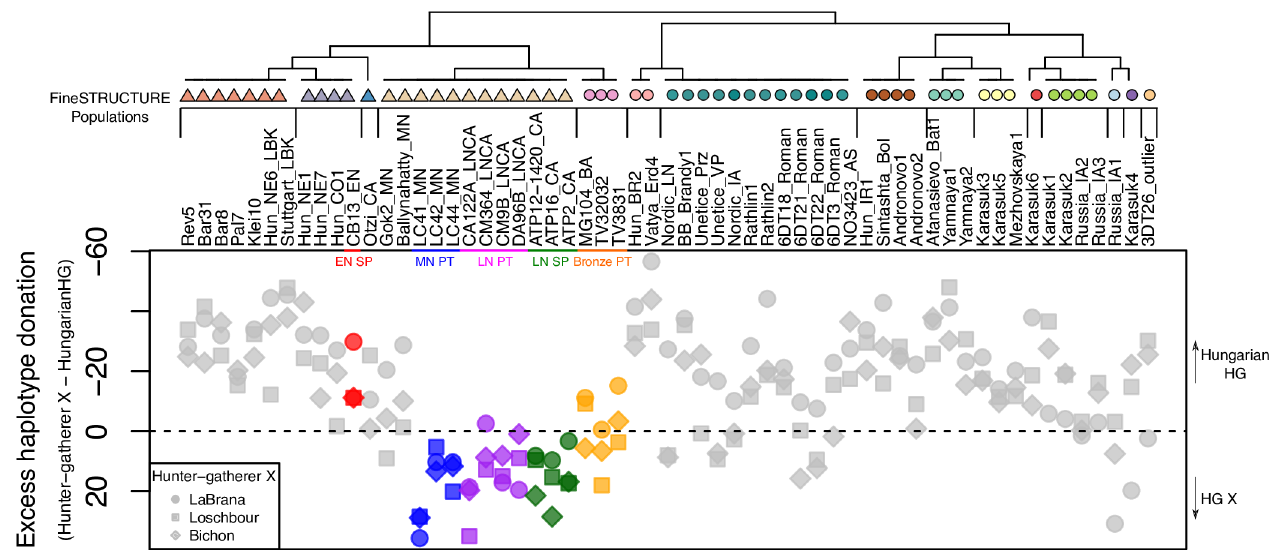
Fig 2. Patterns of hunter-gatherer haplotype donation to ancient Eurasians. This was estimated by subtractingthe vector of haplotype donationof Hungarian HG from a vector of hunter-gatherer X, where X = {LaBrana, Bichon, Loschbour}.Legend: E—Early; M—Middle; L—Late; N —Neolithic; PT—Portugal; SP—Spain. Note: HG individuals were removed from the tree.